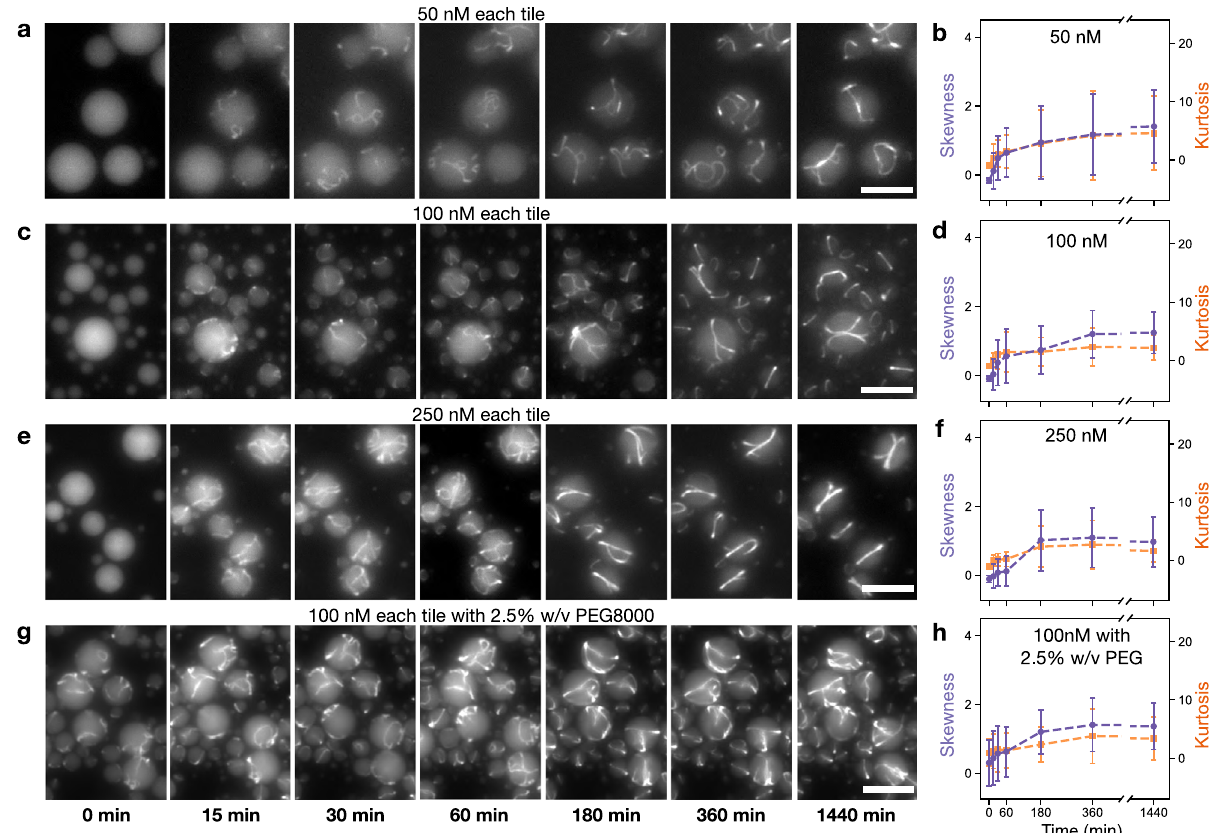
Fig. 3 Isothermal assembly of encapsulated two-tile DNA nanotubes at room temperature. Tiles were pre-annealed and mixed immediately before encapsulation. a , c , e Representative temporal sequence of fl uorescence microscopy images of two-tile nanotubes encapsulated at 50, 100, and 250 nM concentration for each tile. b , d , f Plots of the mean skewness (purple) and kurtosis (orange). g Representative images of two-tile nanotubes encapsulated at 100 nM each tile, with 2.5% w/v PEG. h Plot of the mean skewness (purple) and kurtosis (orange) over time for isothermal assembly of tiles encapsulated with PEG. Data were presented as mean values± standard deviation. Data extracted using droplet detection code as described in Supplementary Note S4.13. Number of droplets sampled and histogram data of radii for sampled droplets in Supplementary Notes S5.9 and S5.10. Source data for this fi gure is provided as a source data fi le. Scale bars: 20 μ